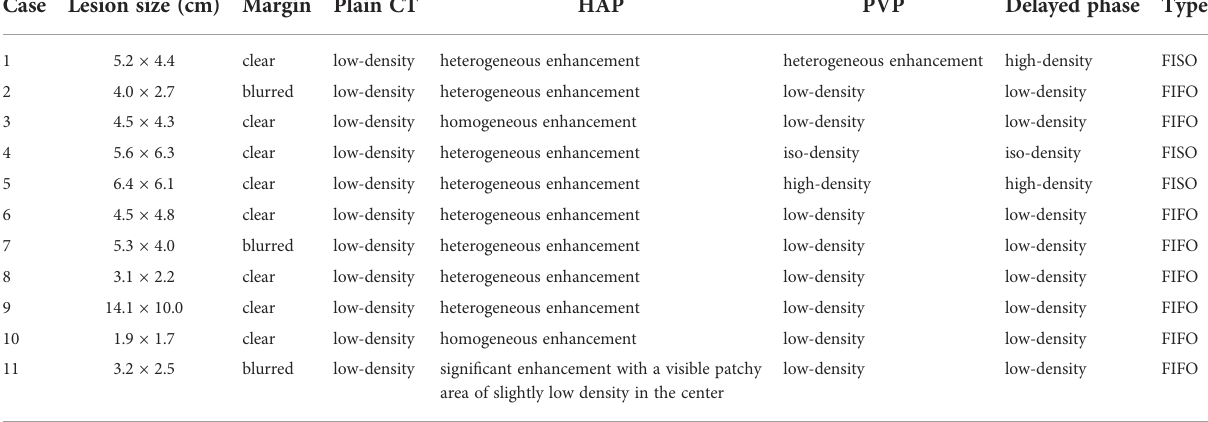
TABLE 2 Summary of CT/CECT fi ndings in patients.